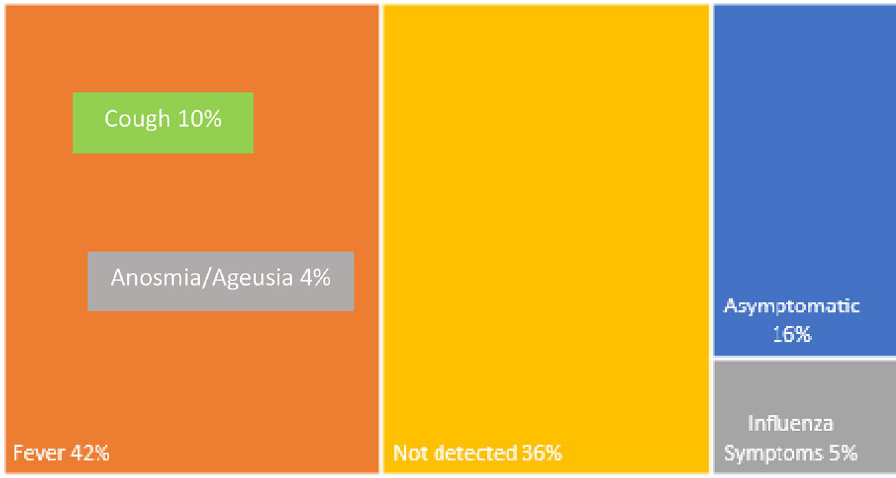
Figure 4. Anamnestic symptoms in IgG positive